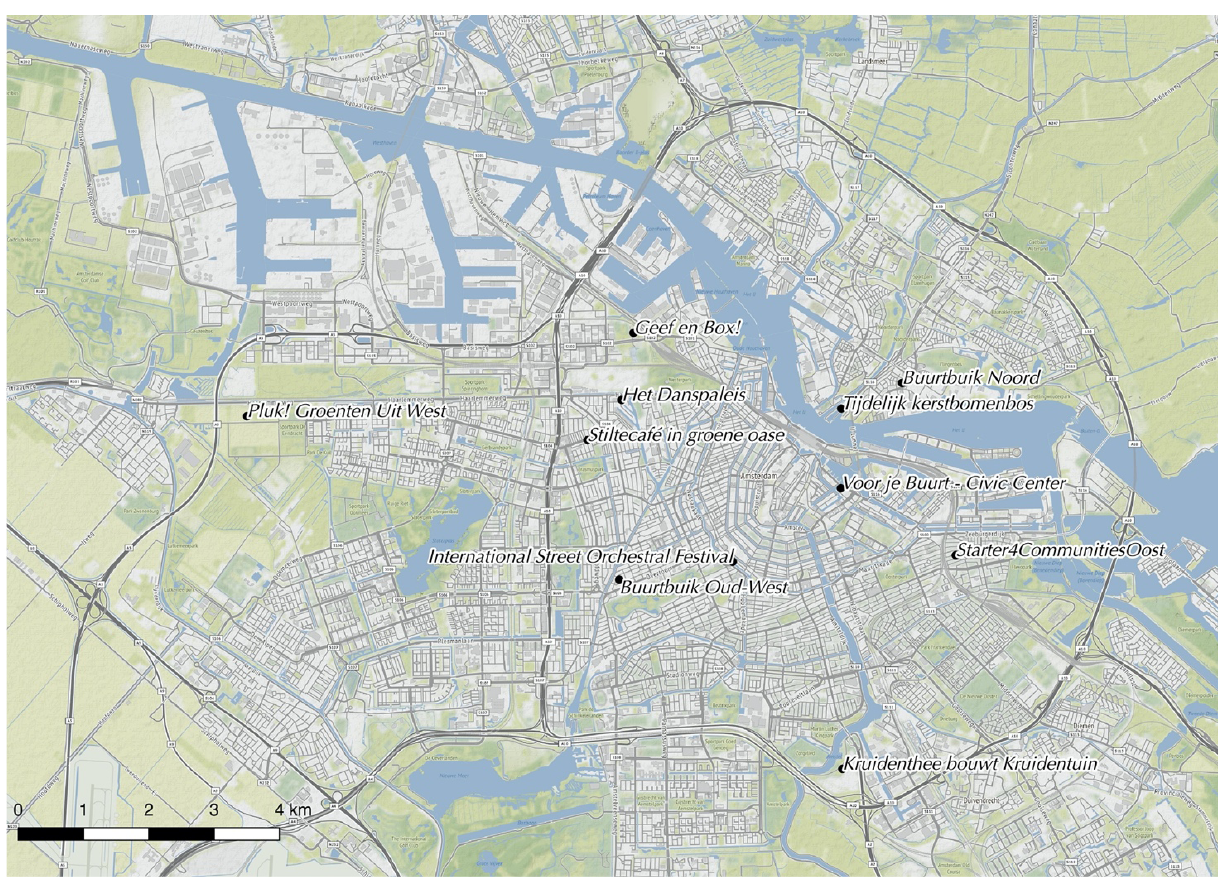
Figure 2. Civic crowdfunding realised projects in Amsterdam, 2018. Source: Author. 2014). As this quote from an anonymous civic crowdfund- ing project in Milan